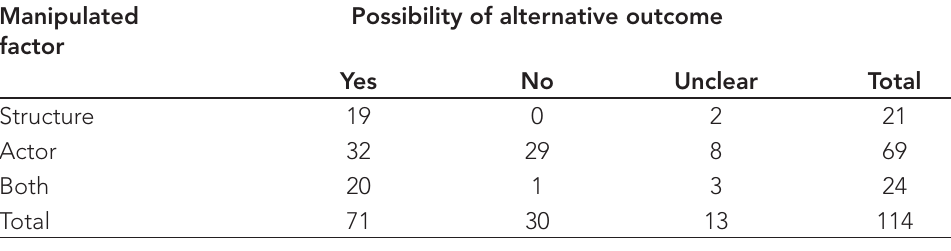
Table 2: Categorization of counterfactuals based on manipulated factor and possibility of alternative